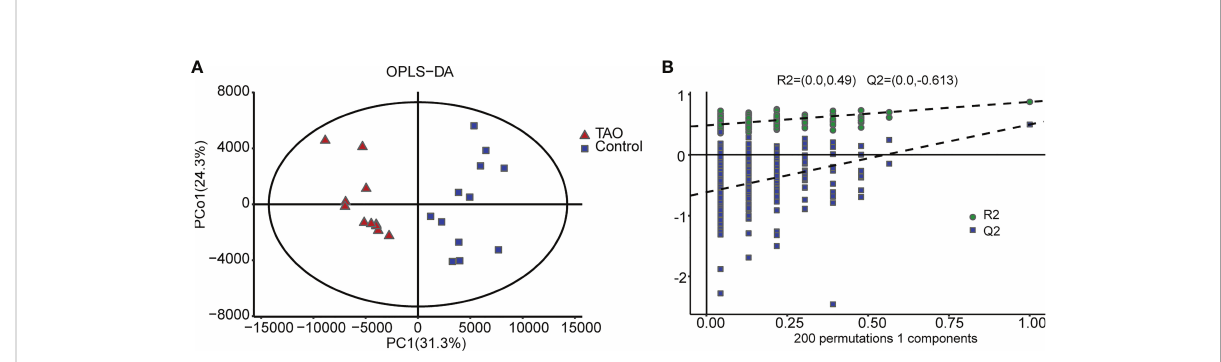
FIGURE 1 Orthogonal partial least-squares discrimination analysis (OPLS-DA). (A) The OPLS-DA score plot clearly discriminates thyroid-associated ophthalmopathy (TAO) group from the control group. (B) Validation plots of 200 permutation tests of the OPLS-DA model for TAO group and normal